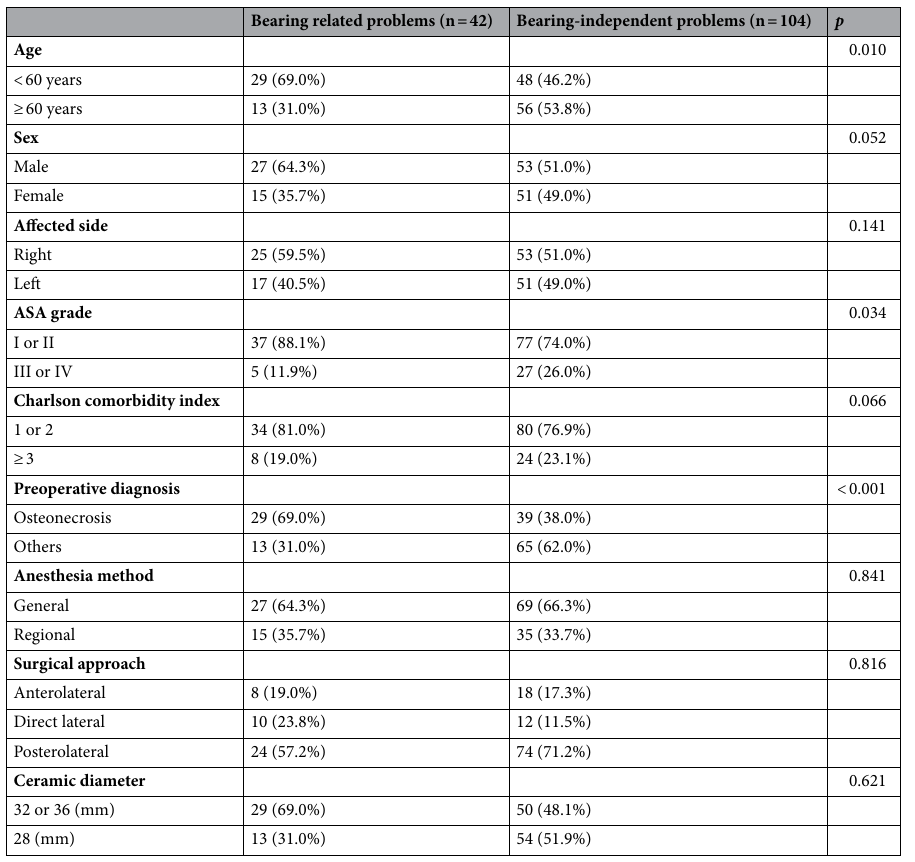
Table 4. Factors associated with bearing-related